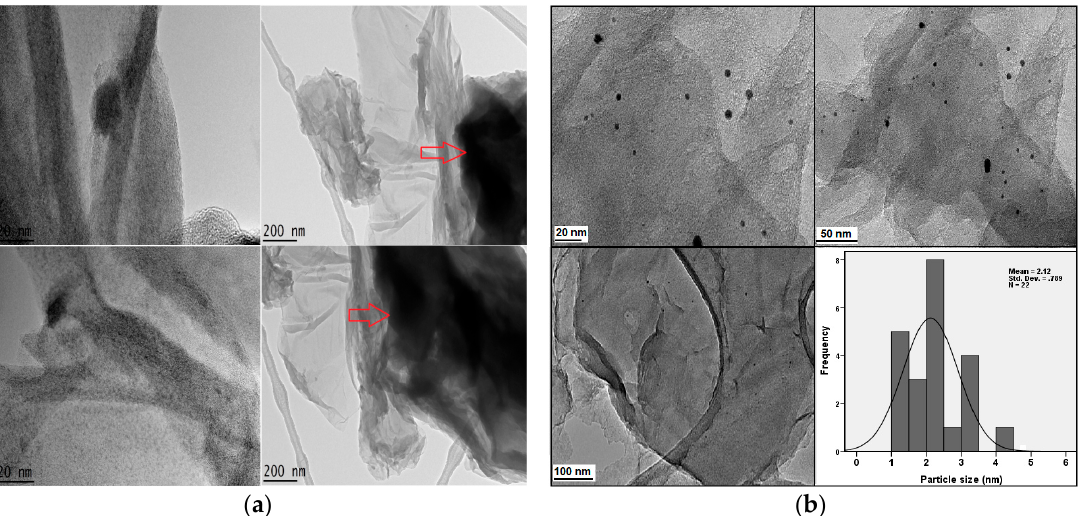
Figure 5. ( a ) TEM micrographs of protocatechuic acid loaded on GO/Gd nanocarrier (GAGPA) at high and low magnifications; ( b ) TEM micrographs of protocatechuic acid loaded on GO/Gd nanocarrier after surface coating with gold nanoparticles (GAGPAu);